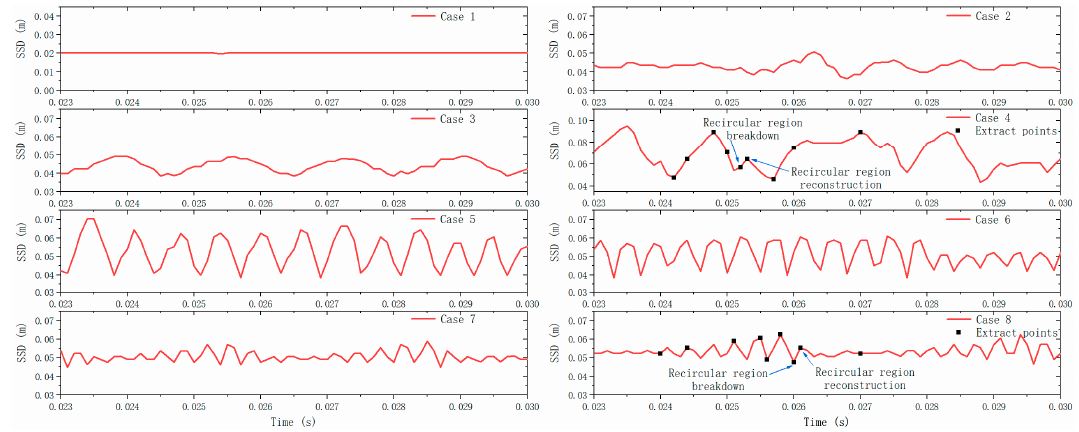
Figure 6. Shock wave distance (SSD) of R7 jet in 0.023–0.030 s.